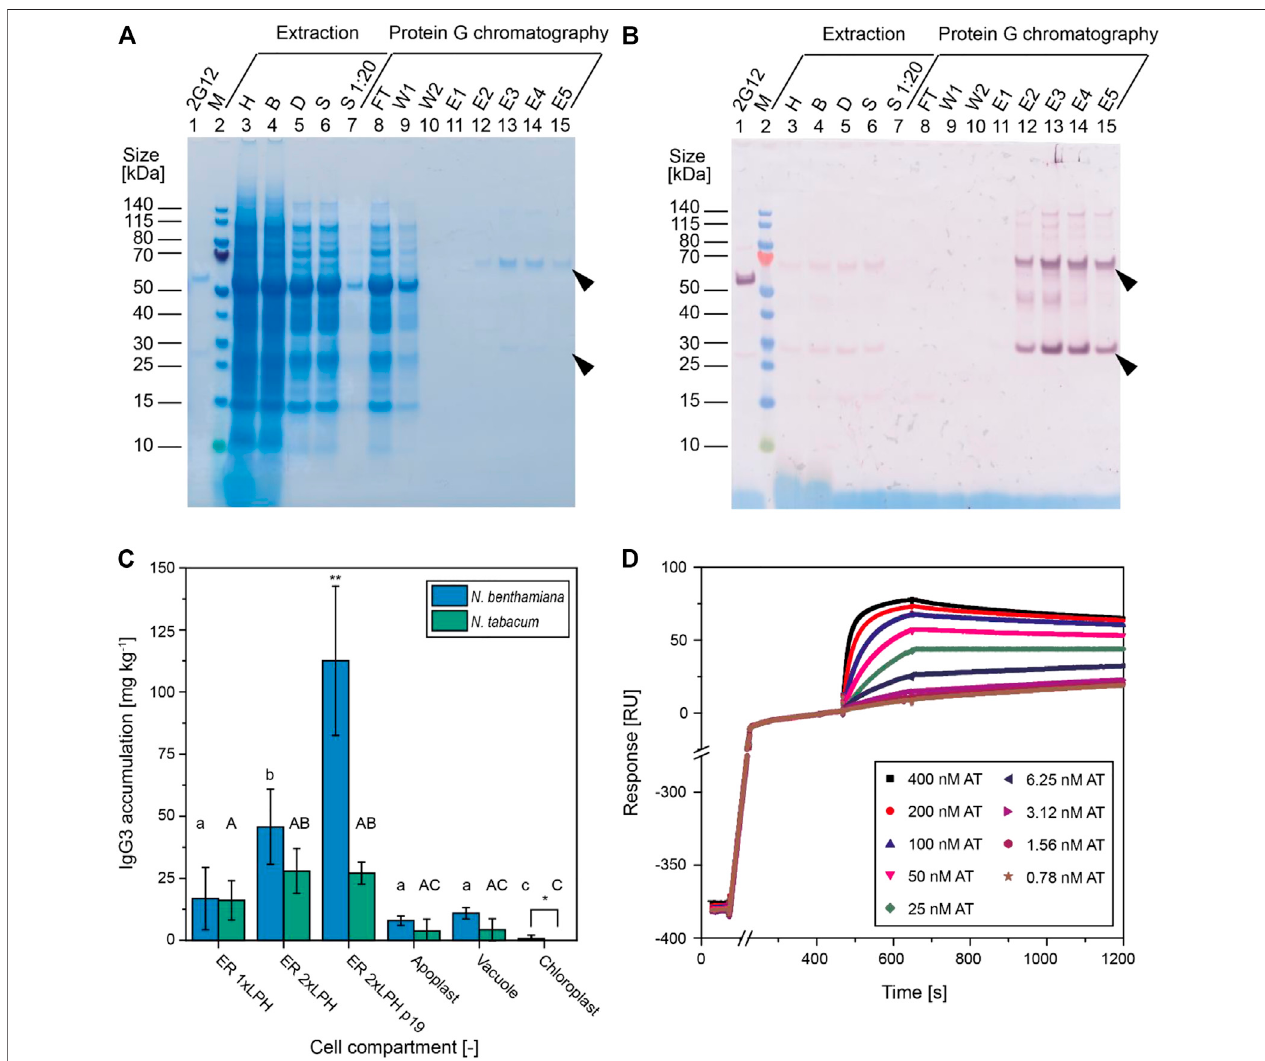
FIGURE 2 | Expression of IgG3 mAbs in Nicotiana spp., laboratory-scale puri fi cation, and assessment of functionality. (A , B) Samples from IgG3 puri fi cation were analyzedonaCoomassiestainedLDSgel (A) andbywesternblot (B) usingAP-labeledgoatanti-humanIgGandgoatanti-humanIg λ antibodies. (C) IgG3accumulation levels in differentiated N. benthamiana and N. tabacum plants as measured by SPR. IgG3 accumulation levels correspond to constructs featuring a CHS 5 ′ UTR (p19 (cid:2) co-in fi ltration with p19 silencing suppressor, 2 × LPH - construct with duplicated LPH leader sequence). Data are means ± standard deviations from 3 – 6 plants. Signi fi cant (alpha 0.05, p -value ≤ 0.05, two-sided, two-sample Welch ’ s t -test) differences between compartments using the same species are denoted by letters (lower case for N. benthamiana , upper case for N. tabacum ) whereas differences between species in the same compartment are denoted by * and a ** indicates a signi fi cant difference to all other data. (D) Puri fi ed IgG3 antibodies were captured on a protein G-coated SPR sensor and 14 different concentrations (0.024 – 400 nM) of recombinant alpha toxin were injected. Data in D are raw resonance units without correction for baseline drift, recorded on a Biacore T200 with ER-derived IgG3. Alpha toxin concentrations < 0.780 nM are omitted for clarity. Black block arrows indicate the expected molecular mass of heavy and light chains. H – homogenate, B – bag fi ltrate, D – depth fi ltrate, S – sterile (0.2 µm) fi ltrate, FT – fl ow-through, W1 – running buffer wash, W2 – pH 8.0, 5 mS cm − 1 wash, E1 – 5 – protein Geluate, AT – S. aureus alpha toxin, ER – endoplasmic reticulum, LPH – N-terminal leader peptide of the antibody mAb24 heavy